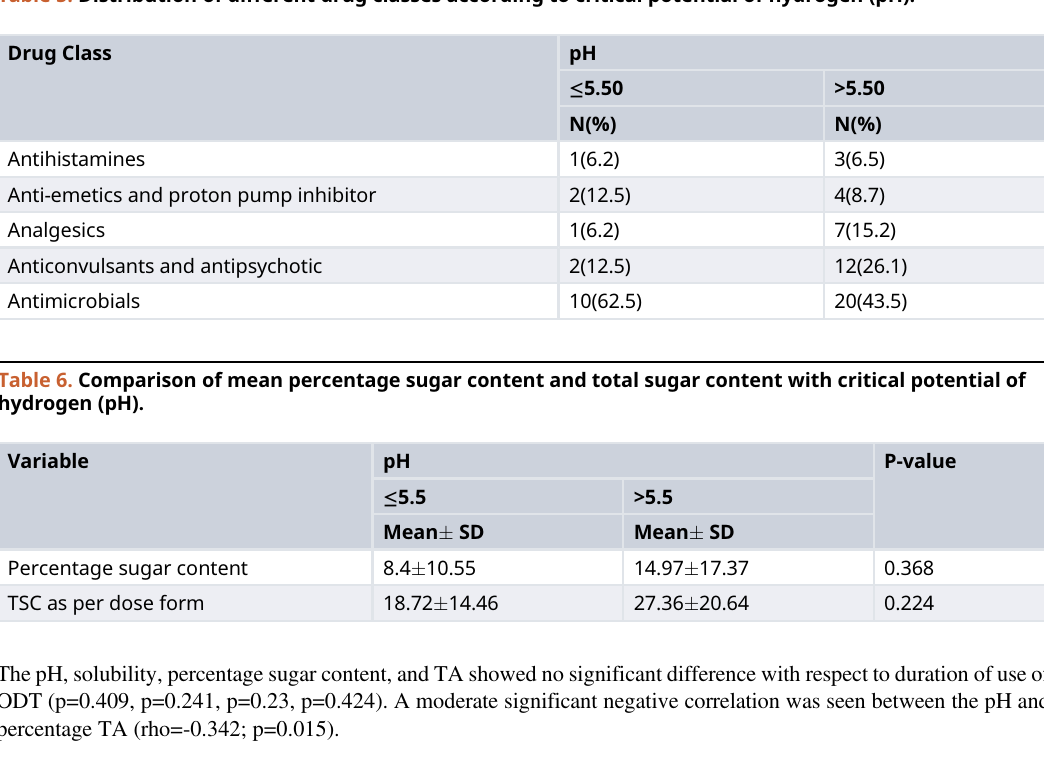
Table 5. Distribution of different drug classes according to critical potential of hydrogen (pH).